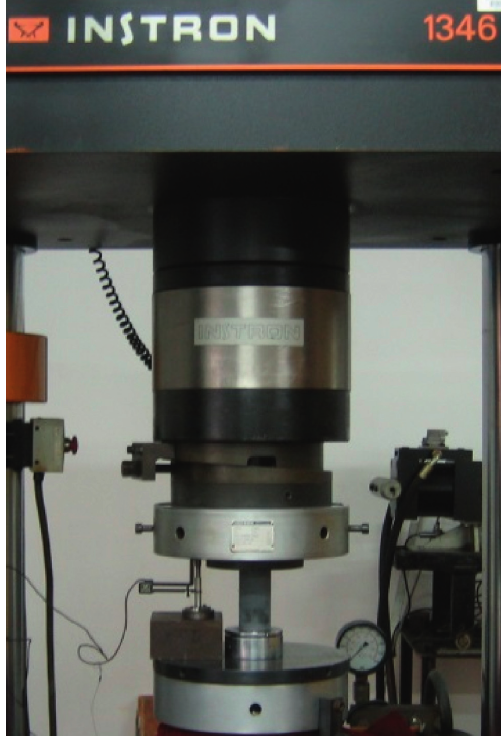
Figure 3: Creep experiment of the iron